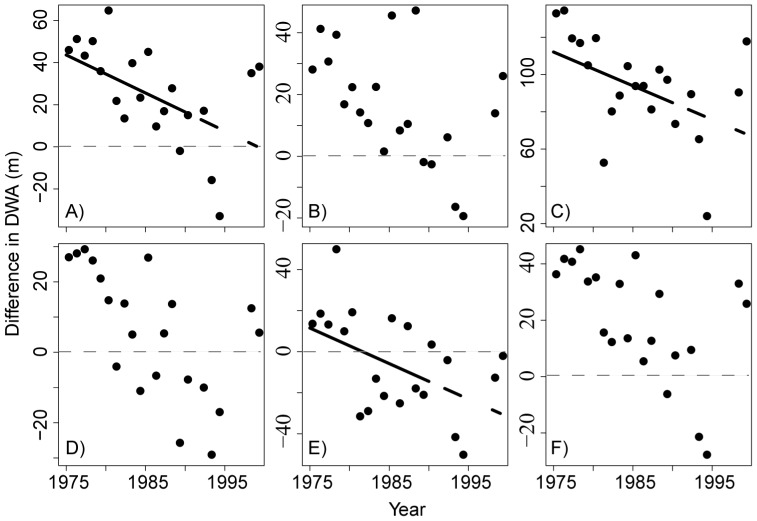
Difference in density-weighted average depth of zooplankton groups with all phytoplankton from 1974-1998.Zooplankton groups include copepodites (A), nauplii (B), adult copepods (C), rotifers (D), and cladocerans (E). Panel F shows all zooplankton combined versus all phytoplankton. A y-value of zero (dashed line) indicates that zooplankton and phytoplankton have the same density-weighted depth, while positive and negative values indicate that groups are deeper or shallower than the phytoplankton, respectively.